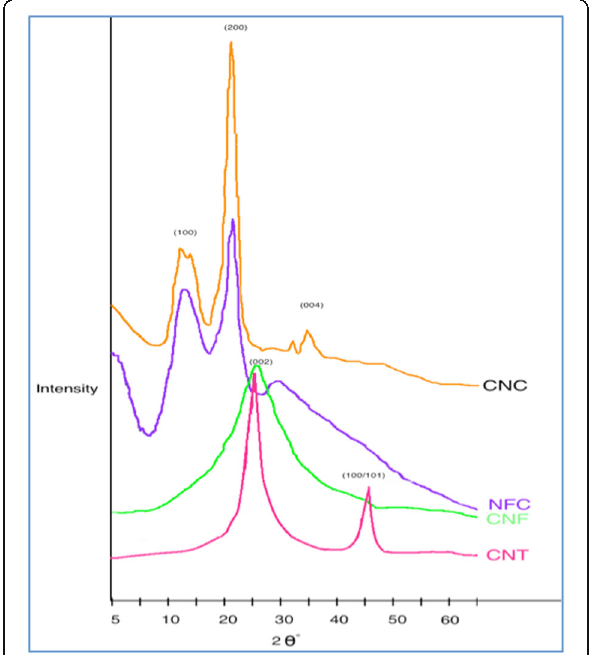
Fig. 2 XRD pattern of nanomaterials